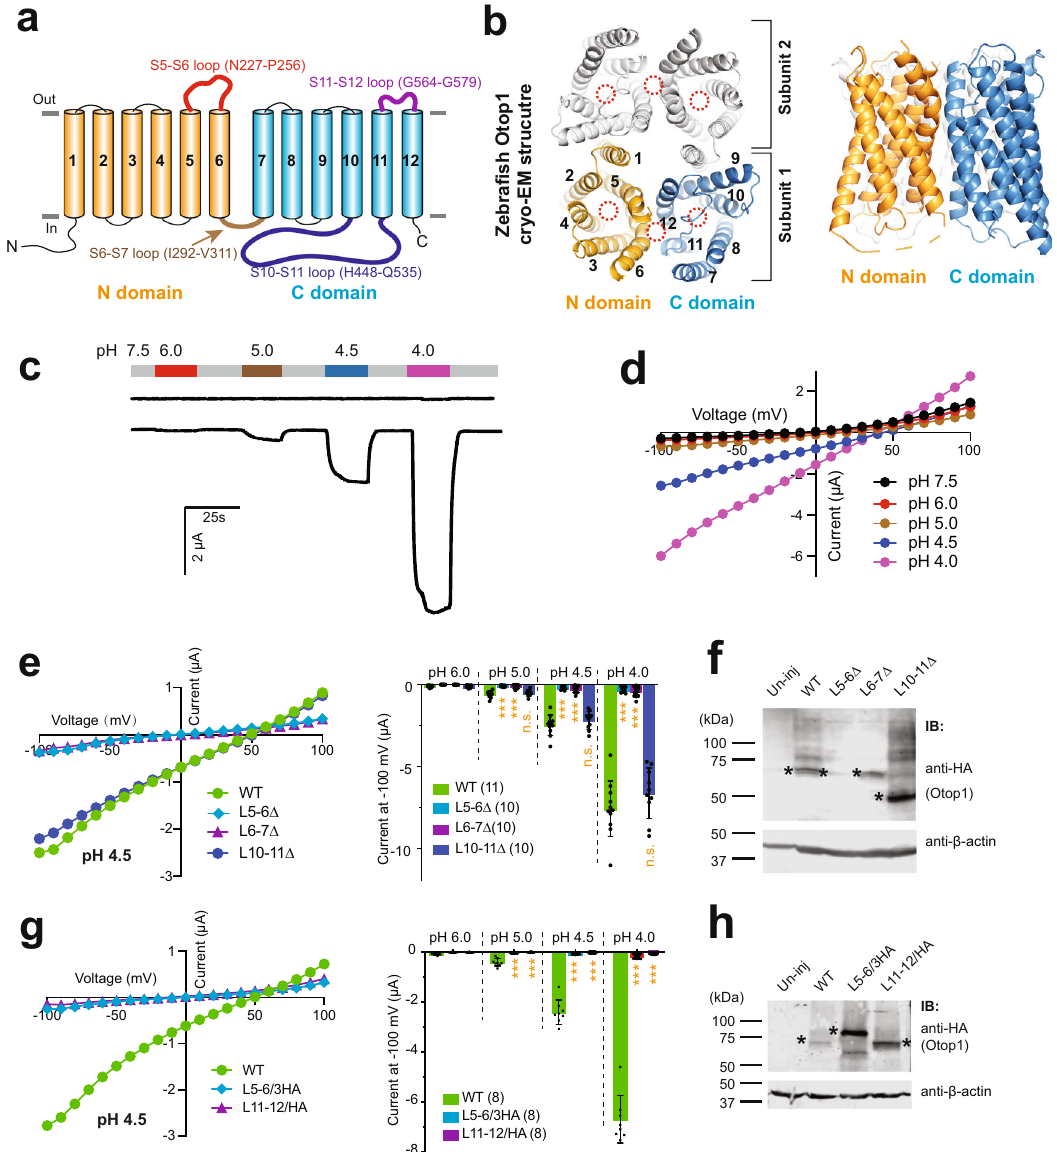
Fig. 1 The extracellular S5 – S6 loop and the S11 – S12 loop are essential for Otop1 function. a The putative transmembrane topology of the human Otop1 channel, showing the N (transmembrane segments S1 – S6) and C (S7 – S12) domains, the loops connecting the TM segments, and the intracellular termini. Loops studied in this work are indicated. b The top (left) and side (right) views of the zebra fi sh Otop1 channel (PDB 6NF4) 23 . The numbers of the transmembrane segments are indicated on one of the subunits on the left. The three putative pores formed within the N and C domains and the intrasubunit interface between the two domains are indicated by dotted red circles. c Representative recording showing the currents of un-injected and human Otop1-injected oocytes at indicated pHs. Oocytes were clamped at − 60 mV. d Representative current – voltage relationship ( I – V curve) of human Otop1 channel at indicated pHs. e , g Left: the representative I – V curves of the indicated WT and mutant Otop1 channels. Right: the scatter plot and bar graph showing the currents of the indicated channels recorded at − 100 mV at the indicated pHs. L5 – 6 Δ : S5 – S6 loop deletion mutant; L6 – 7 Δ : S6 – S7 loop deletion mutant; L10 – 11 Δ : S10 – S11 loop deletion mutant; L5 – 6/3HA: the mutant with the S5 – S6 loop replaced by three fused HA tags; L11 – 12/HA: the mutant with the S11 – S12 loop replaced by an HA tag. Data in the bar graphs are presented as mean ± SD. Currents of the mutants were compared to that of the WT with Student ’ s t -test (*** P < 0.001, n.s.: no signi fi cance). Oocyte numbers for scatter plots and bar graphs are indicated in parentheses. f , h Western blot images show the expression of the indicated Otop1 channels. Asterisks indicate the monomer bands of the WT and mutant proteins. Both L5 – 6/3HA and L11-12/HA gave stronger signals since they contain more than one copy of the HA tag. Mutant L5 – 6/3HA ran at a higher position on the gel for an unknown